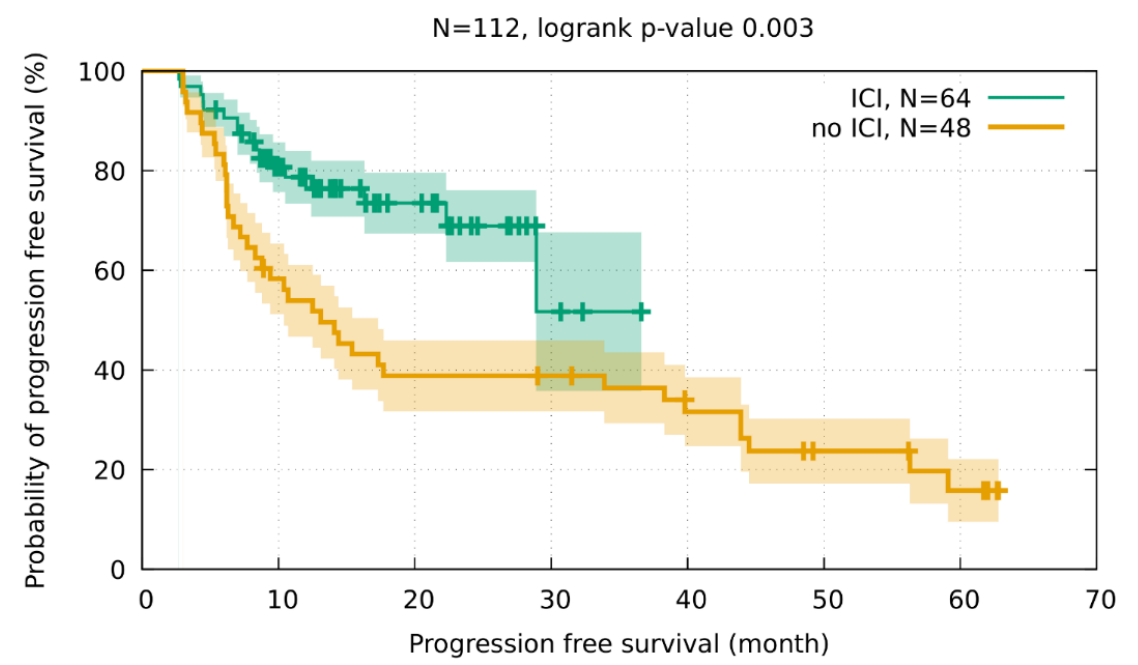
Figure A2. The comparison between subgroups revealed a significantly better progression-free survival for patients with immunotherapy (logrank p -value = 0.003).